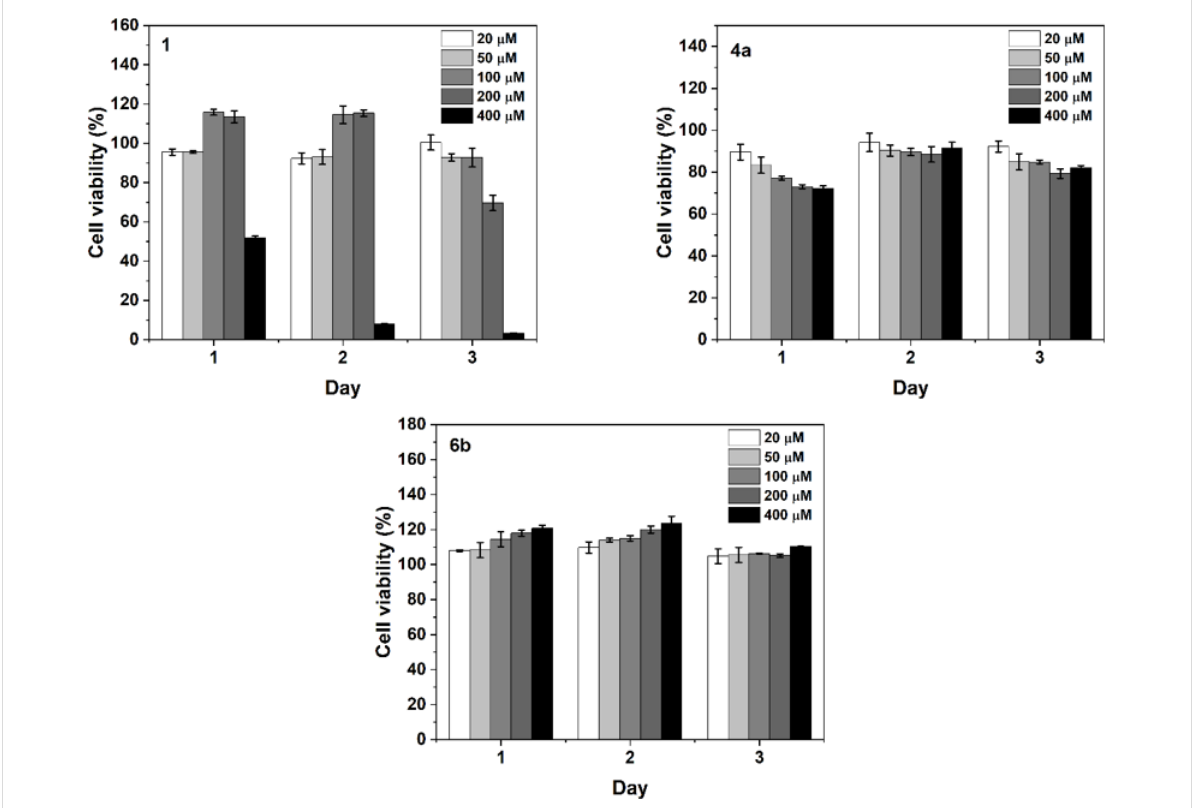
Figure 2: Cell viability of HeLa cells treated with 20 μ M, 50 μ M, 100 μ M, 200 μ M and 400 μ M of 1 , 4a and 6b for 1, 2, and 3 days.